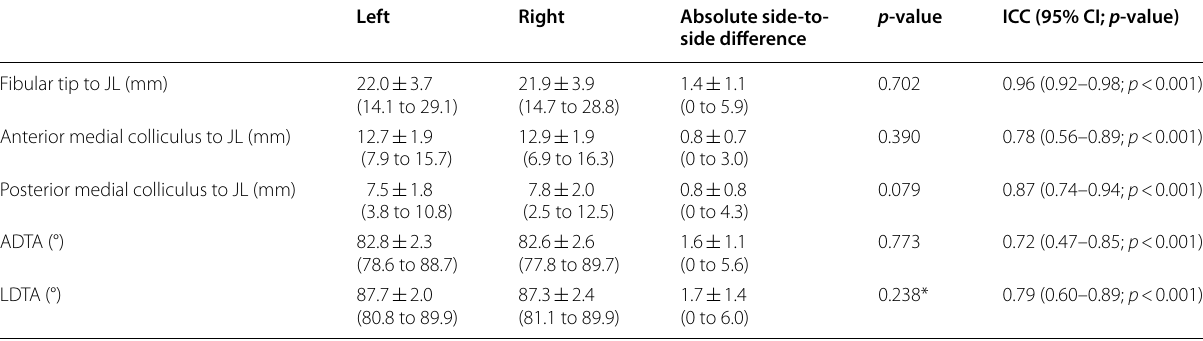
Mean standard deviation (range) are reported. *Wilcoxon’s rank sum-test, remaining paired ±